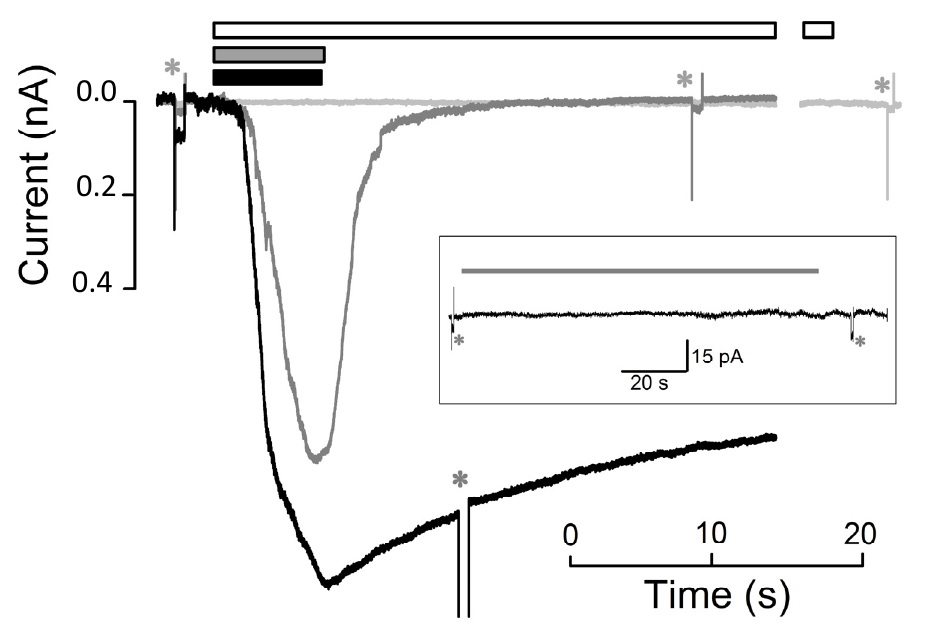
Figure 2. Kinetics of peptide-induced membrane permeabilization of CHO-K1 cells. Whole-cell currents recording elicited by the application (in three different cells), of CM -Tat (6.7 s, 4 µM; black bar and black trace), CM 18 11 and Tat (71 s, 8 µM; white bar and light grey trace; trace break corresponds to 33 s of 11 uninterrupted Tat perfusion); traces were aligned with peptide timing application; 11 = − 20 mV. Inset, 113 s application of 3 µM of CM V h 1.0 G Ω after CM -Tat application. Asterisks indicate − 10 mV pulse delivery, used to 18 11 measure R m